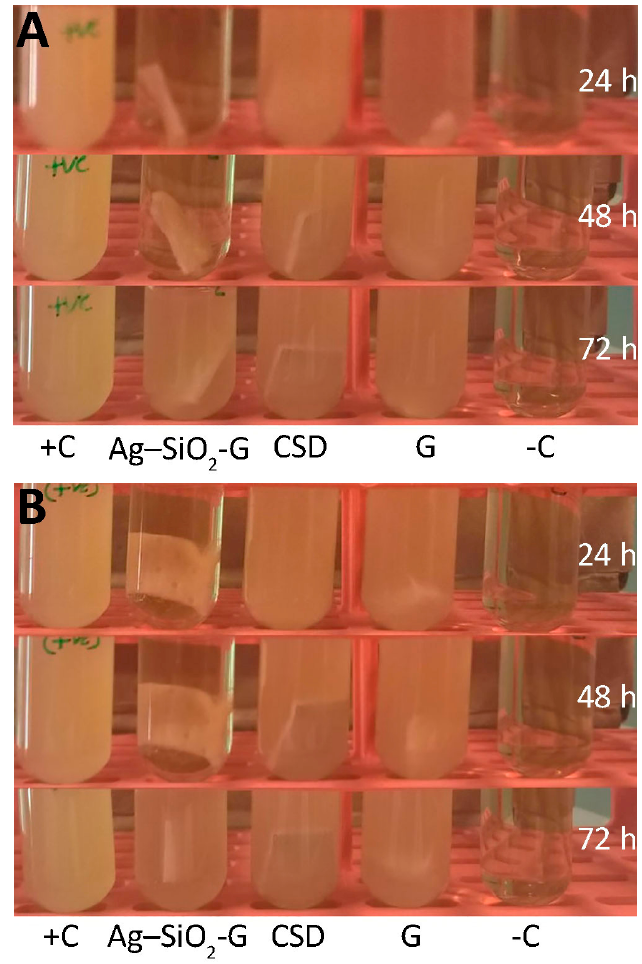
Figure 6. The prolonged antibacterial effects of Ag–SiO 2 -G against ( A ) MRSA and ( B ) E . coli in the Mueller–Hinton broth (MHB) turbidity assays observed after 24, 48, and 72 h of incubation. G, pristine gauze. +C, bacterial suspensions without dressings. –C, MHB without bacteria.